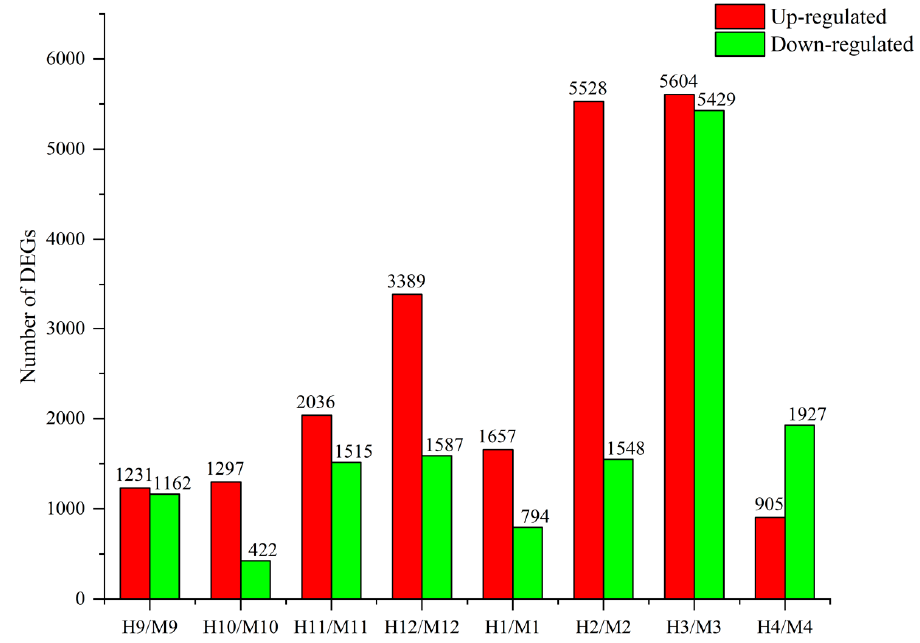
Figure 2. Comparison of differentially expressed genes (DEGs) in different months. Table 3. Numbers and percentages in gene ontology ( GO ) terms of P. edulis ‘Pachyloen’-specific genes.